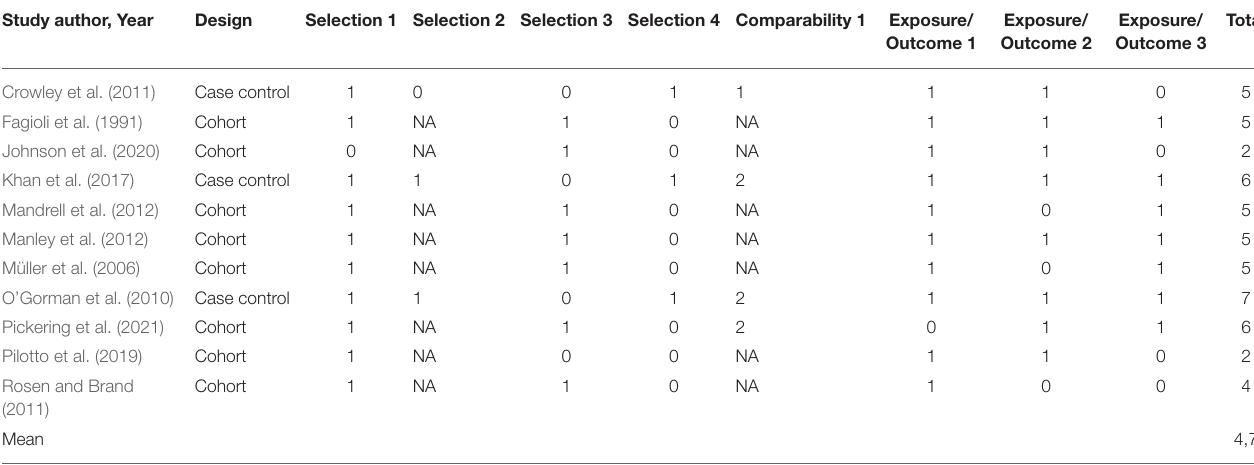
TABLE 2 | Quality appraisal of the ten studies included according to Newcastle Ottawa